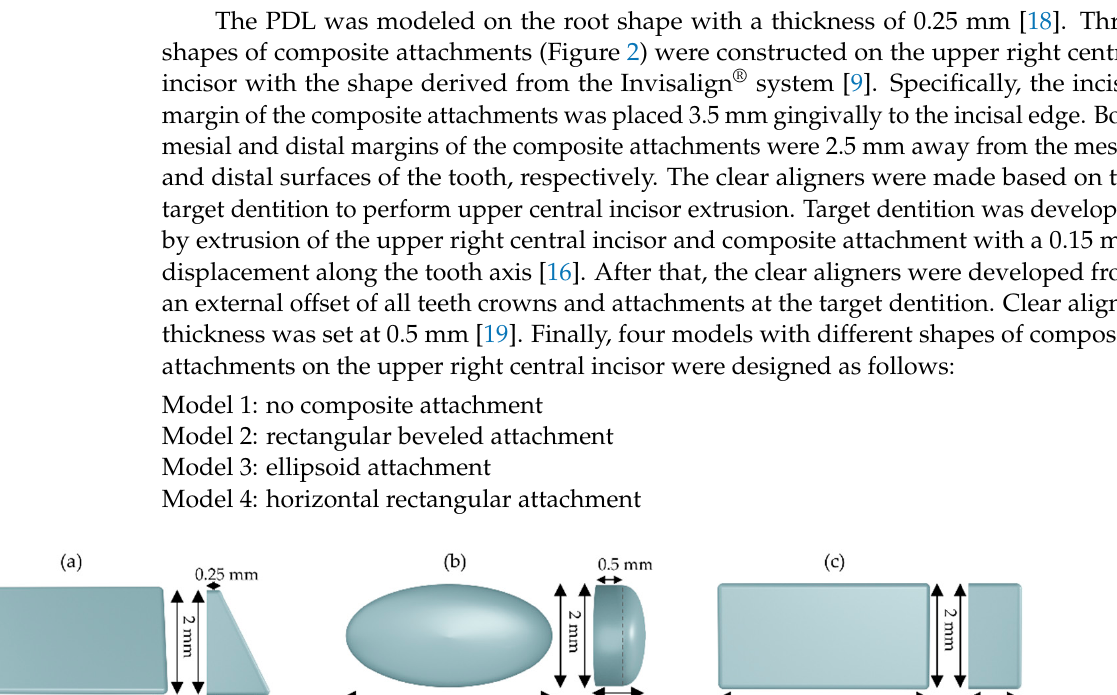
Figure 1. Maxilla model with PDL, upper teeth, clear aligner, and composite attachment: ( a ) 3D model and ( b ) finite element meshing model.